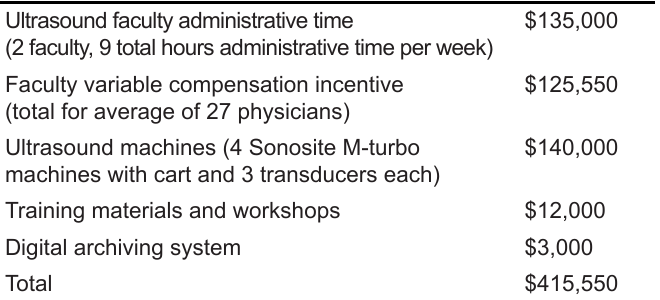
Table 1. Ultrasound training program costs over 2.5